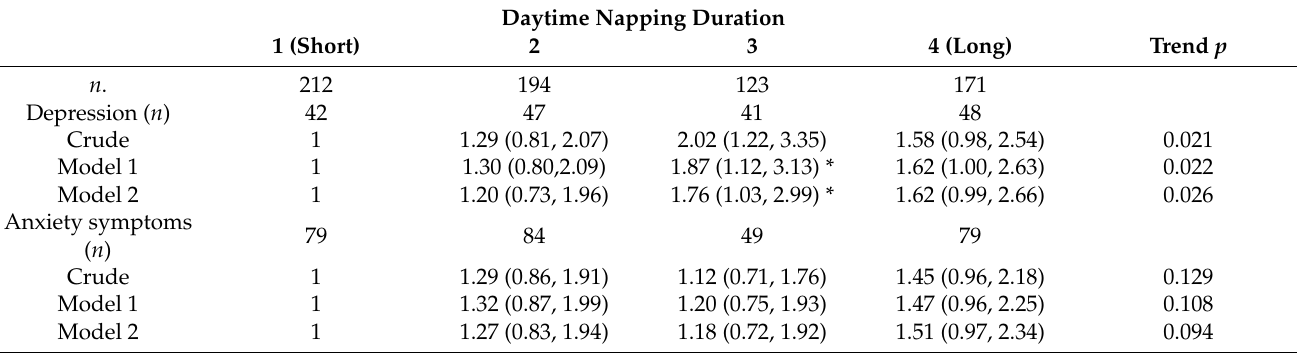
Table 3. Adjusted association between daytime napping duration and mental